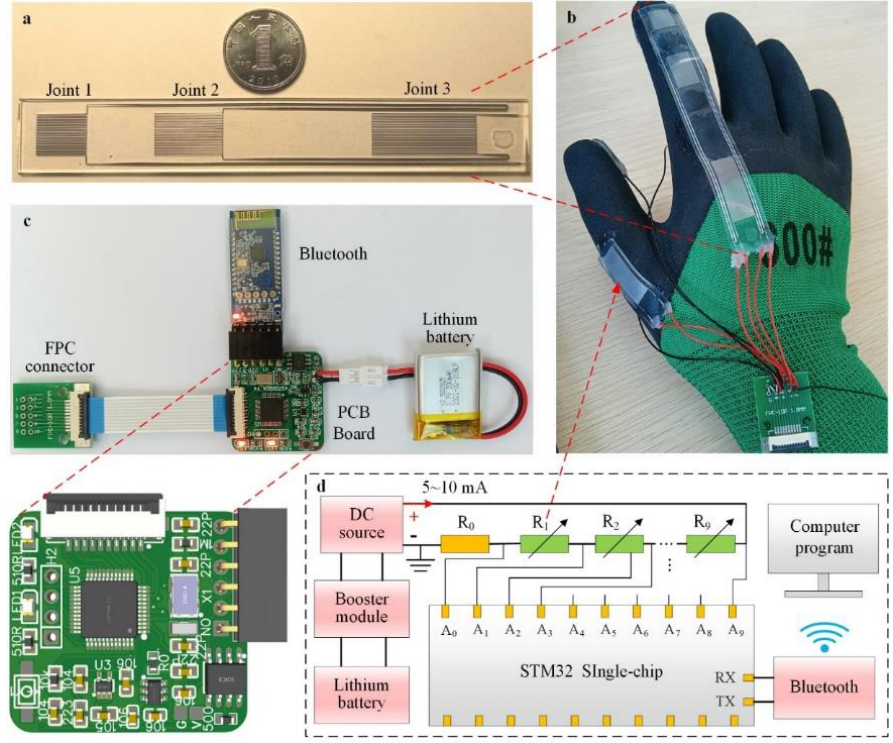
Figure 4. Design of the sensor glove and its signal processing system. ( a ) Sensors on the index finger joint. ( b ) Sensors are assembled in gloves. ( c ) The construction of the circuit control system of sensing gloves, and the enlarged part is the preview of the printed circuit board. ( d ) Schematic diagram of working principle of multi − resistance acquisition circuit.